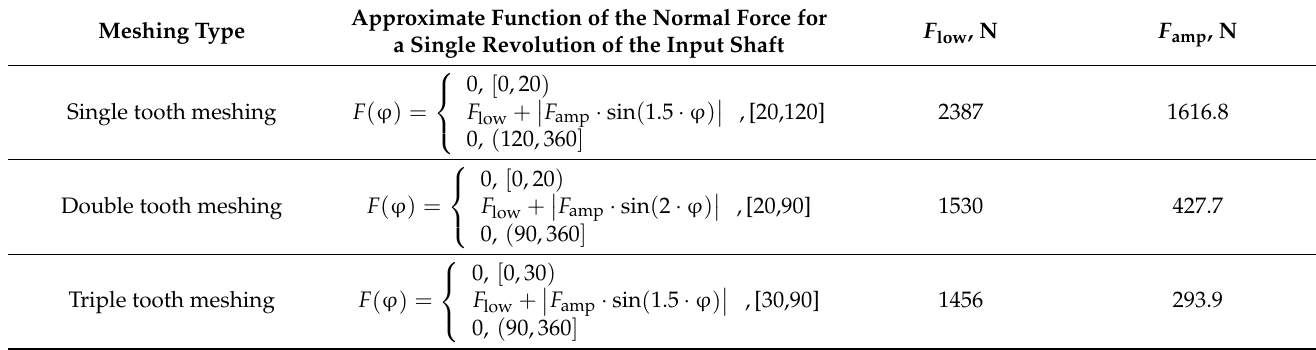
Table 1. Approximate functions of the normal force in the meshing of the cycloid disc teeth and the ring